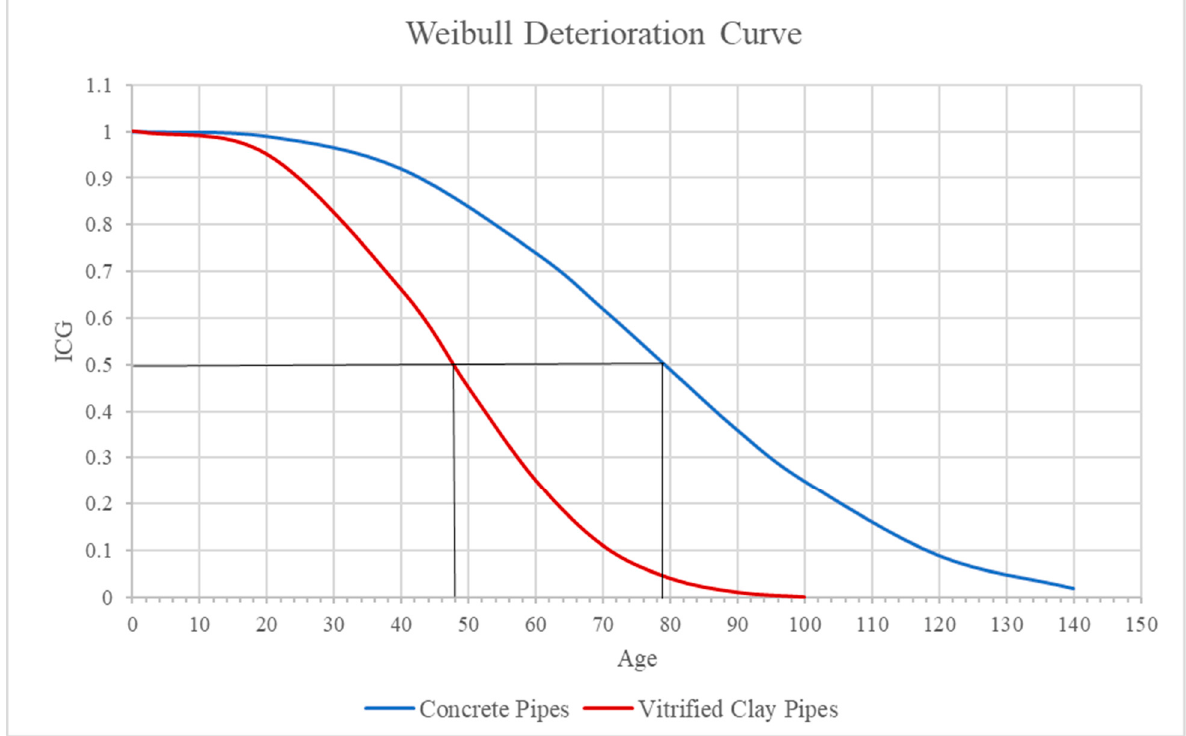
Figure 2. Using an expected service life of 100 years for concrete pipes and 60 years for vitri fi ed clay pipes.